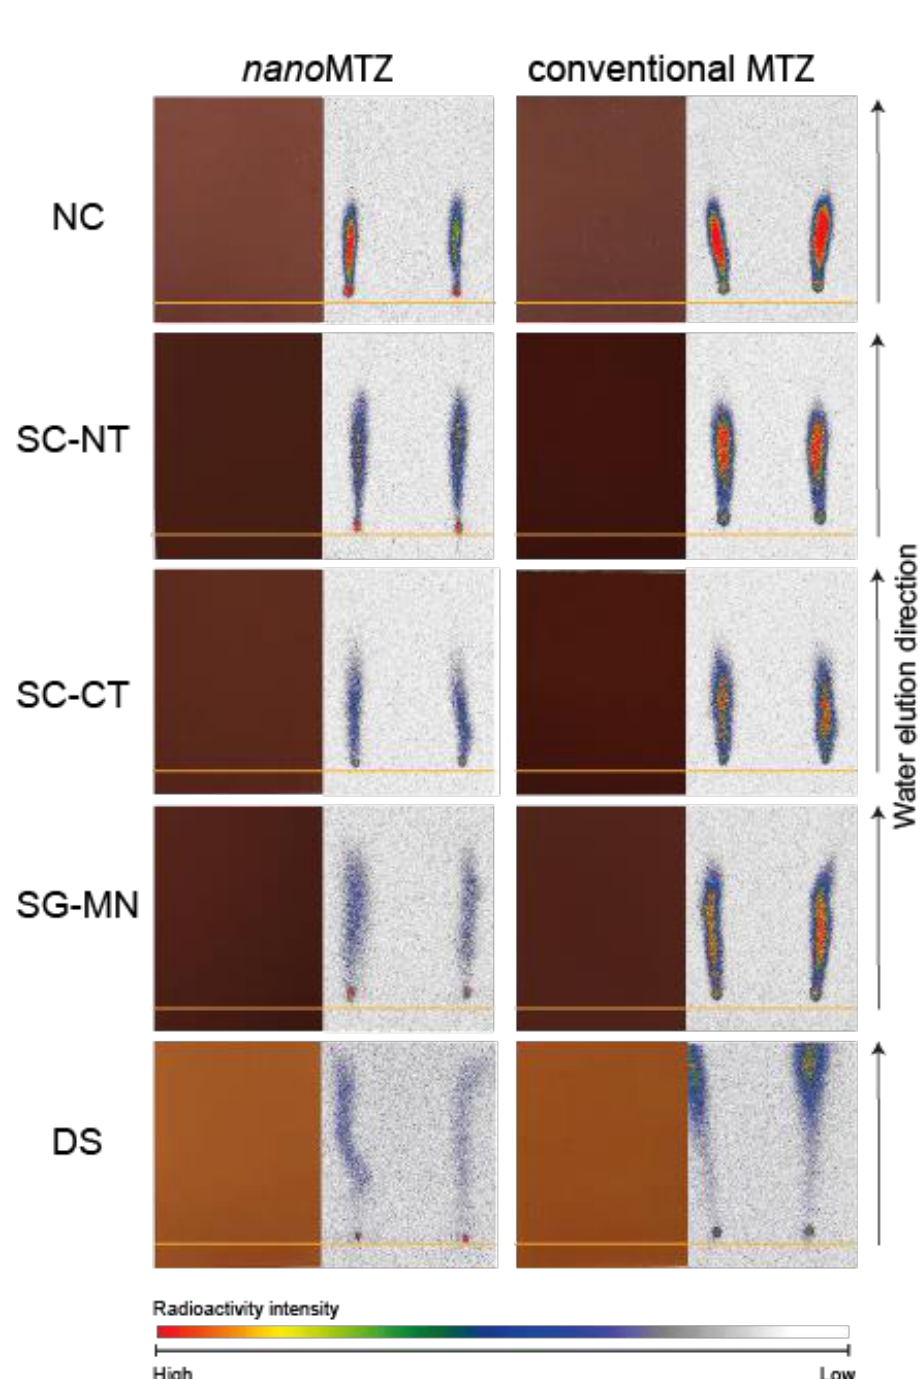
Figure 5. Qualitative mobility data of 14 C-metribuzin with nanoformulation (left column) and conventional formulation (right column), in different soil systems (non-crop soil—NC, cultivated soil with soybean–corn succession in a no-tillage system—SC-NT, cultivated soil with soybean–corn succession in a conventional tillage system—SC-CT, sugarcane monoculture soil—SG-MN, and deep soil—DS). The orange line is the base herbicide application. Images to the right in each column indicate the soil-TLC plate photographs and images to the left in each column indicate TLC plate autoradiographs after water elution and herbicide mobility in the plates. Colors indicate radioactivity signal intensity.